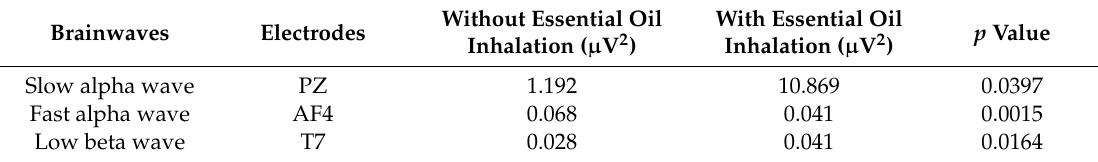
Table 2. Representative brain wave power after inhaled tangerine essential